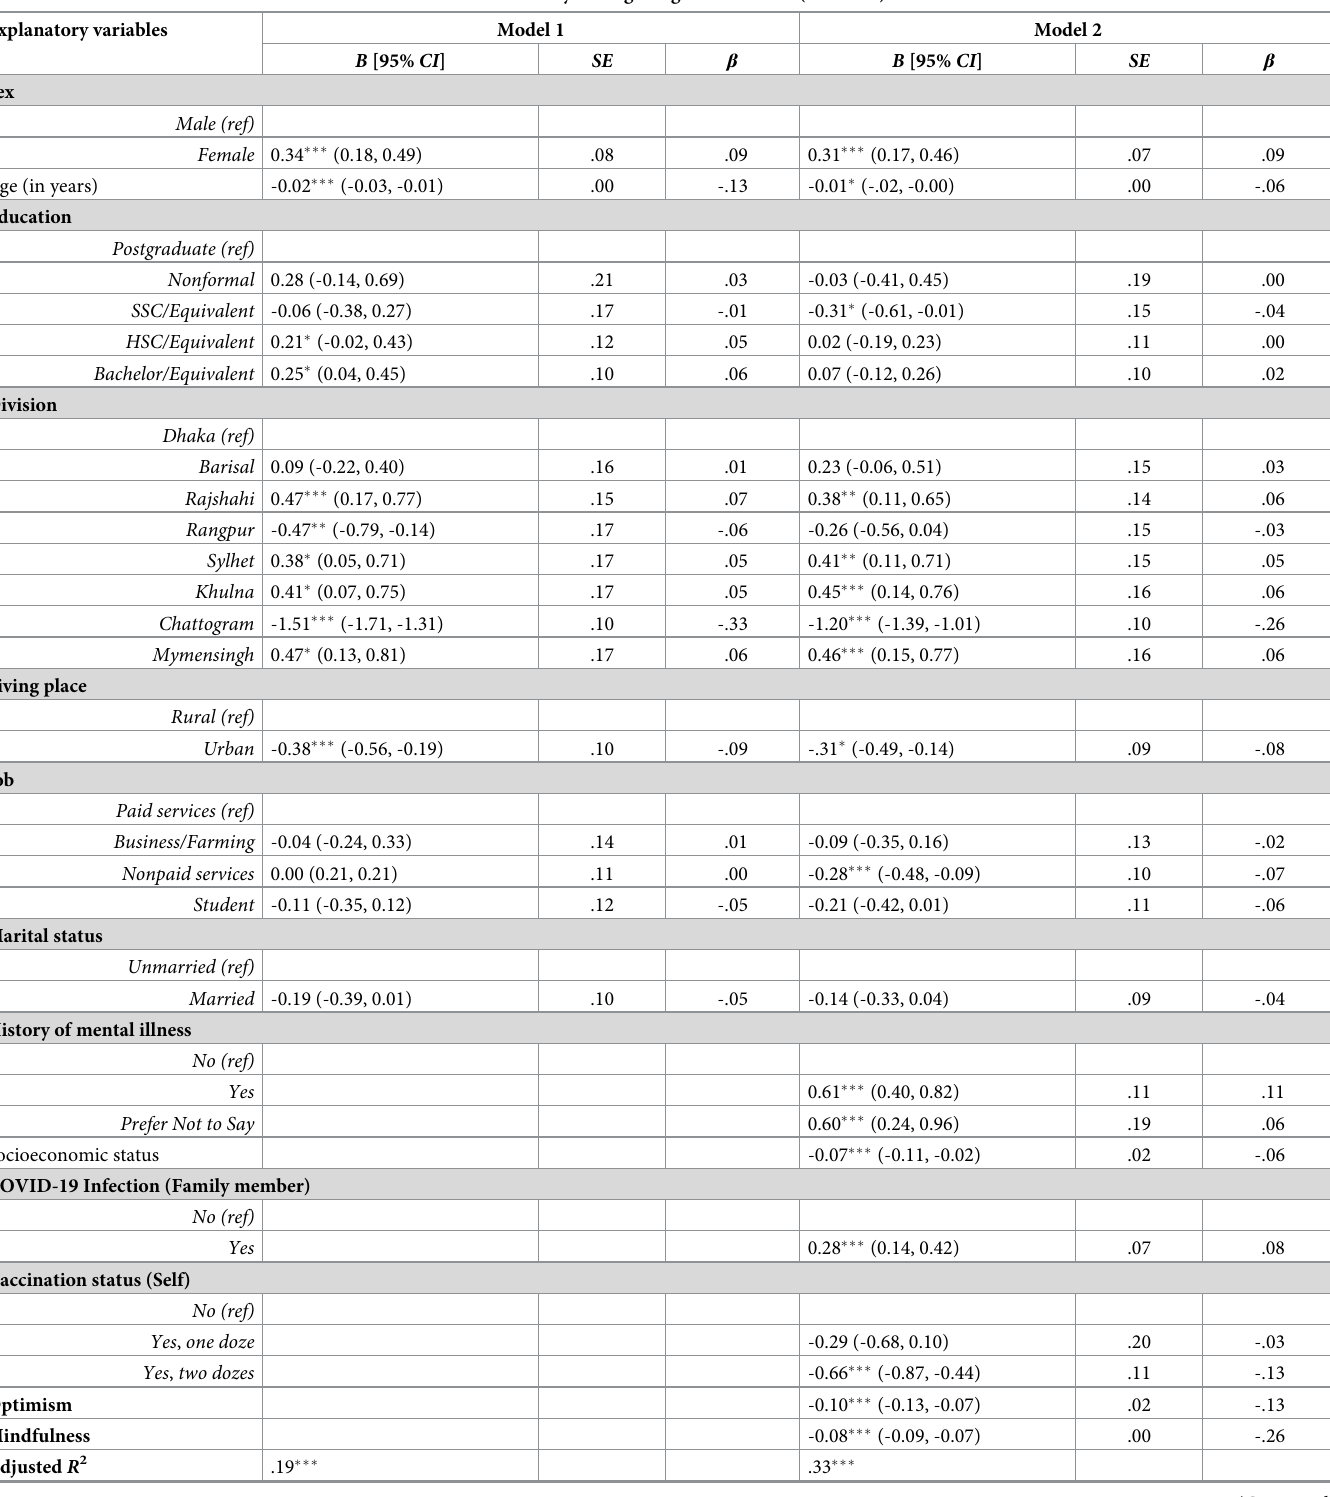
Table 3. Nonmodifiable and modifiable factors associated with anxiety among Bangladeshi adults ( N = 1897). Explanatory